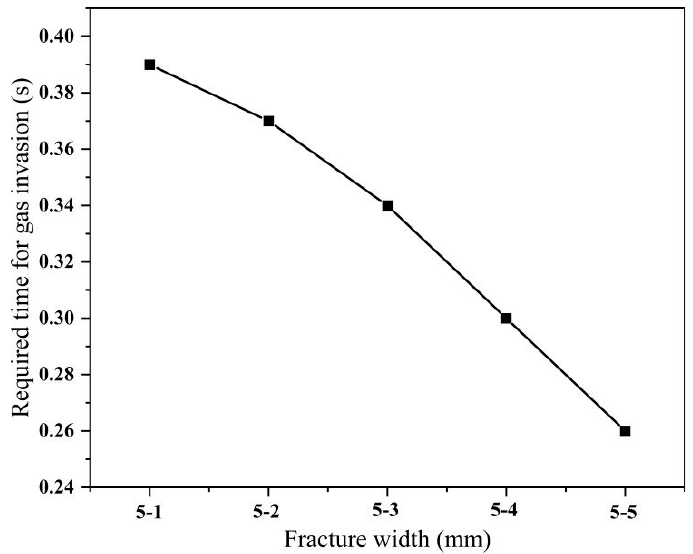
Figure 12. Time required for gas invasion under different fracture widths.